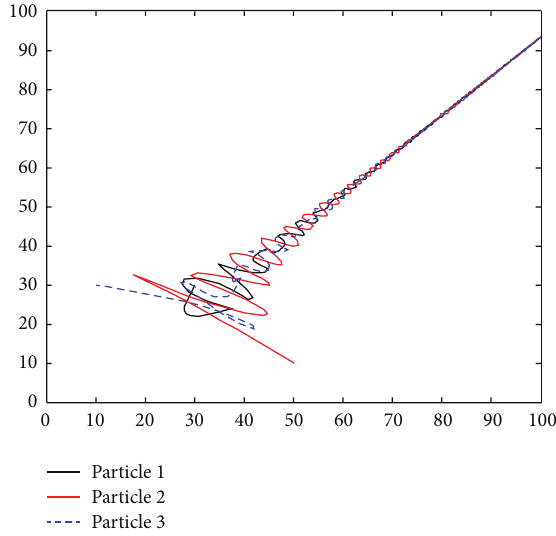
Figure 1: Two-dimensional simulation of (11) for three particles, = 2 , 𝑎 = 100 , 𝑏 = 10 , and ∇ 𝑚 𝑖